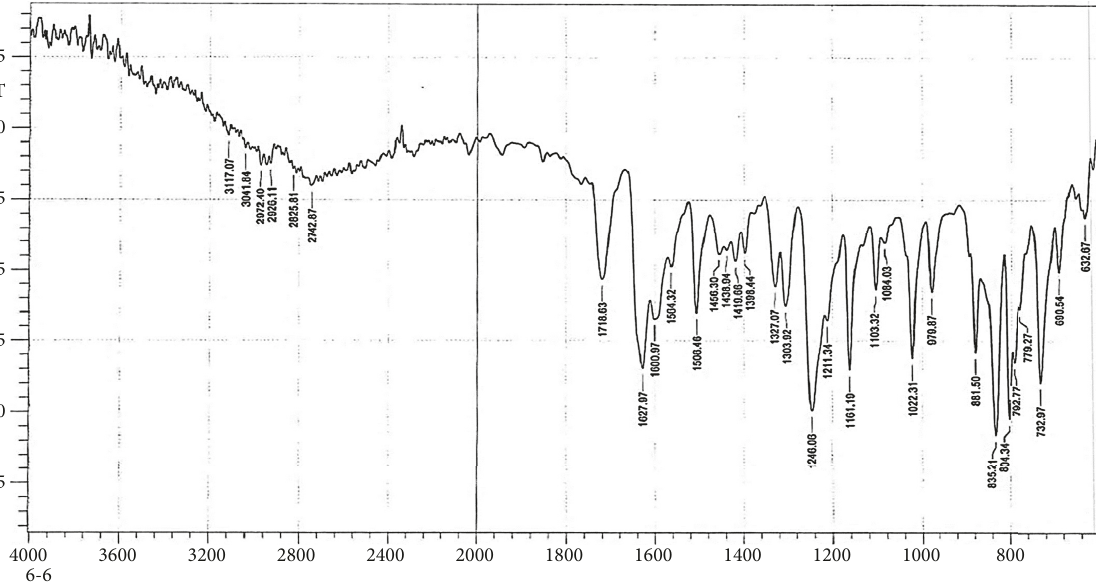
Figure 5: Fourier Transform Infrared Spectrum of C6.